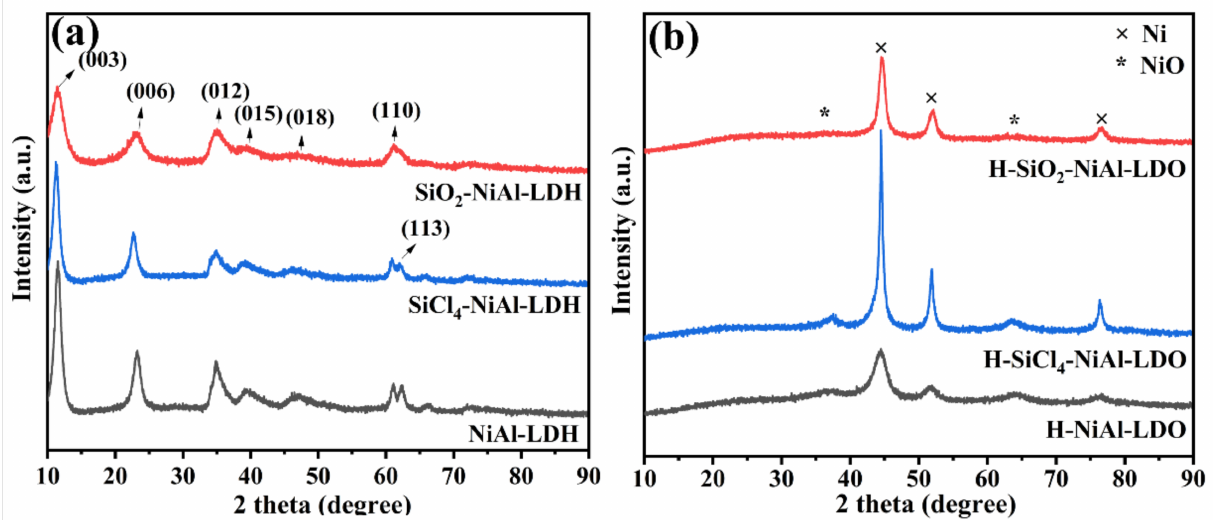
Figure 1. X-ray diffraction patterns of ( a ) NiAl-LDH, SiO 2 -NiAl-LDH, and SiCl 4 -NiAl-LDH and ( b ) H-NiAl-LDO, H-SiO 2 -NiAl-LDO, and H-SiCl 4